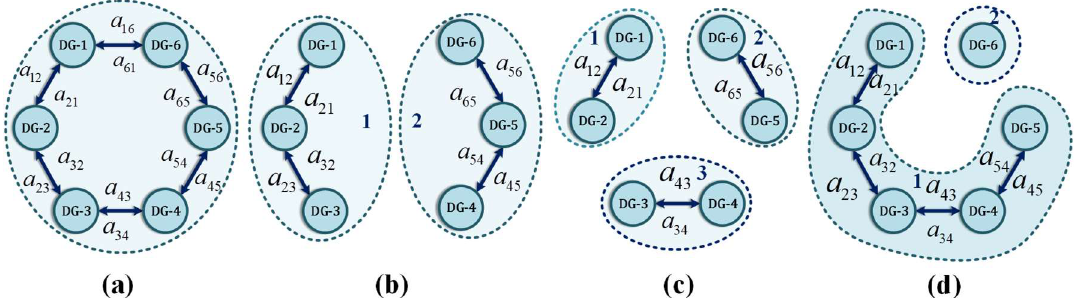
Figure 3. Communication network connectivity: ( a ) Full ring bidirectional connectivity; ( b ) Dual link failure resulting in two symmetrical sub networks; ( c ) Triple link failure resulting in three symmetrical sub networks; ( d ) Dual link failure resulting in two asymmetrical sub-networks.